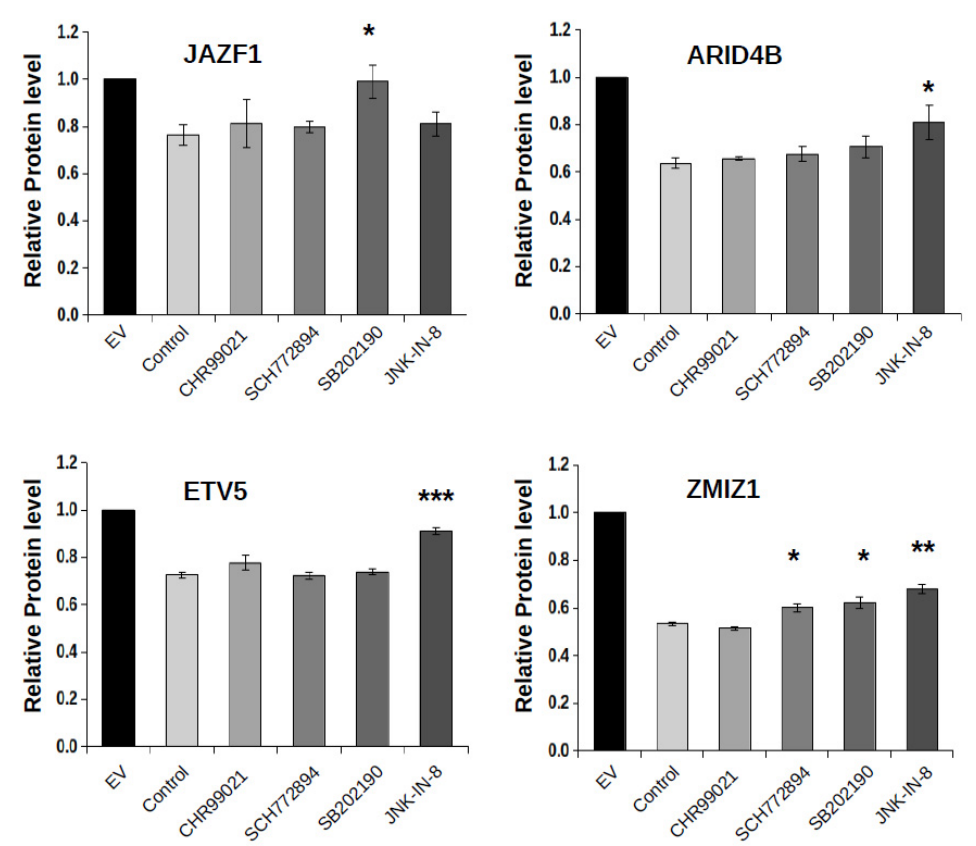
Figure 5. Effects of kinase inhibitors on FBXW7-mediated protein degradation. The ratiometric DsRed/EGFP protein level assay was used to monitor the effects of kinase inhibitor treatments on the level of four different phosphodegron containing full-length proteins in HEK293T cells: JAZF1, ARID4B, ETV5, and ZMIZ1. Inhibitors (CHR99021, GSK3 inhibitor; SCH772984, ERK1/2 inhibitor;